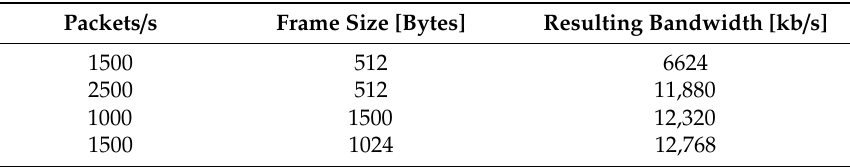
Table 5. Data injection configuration.